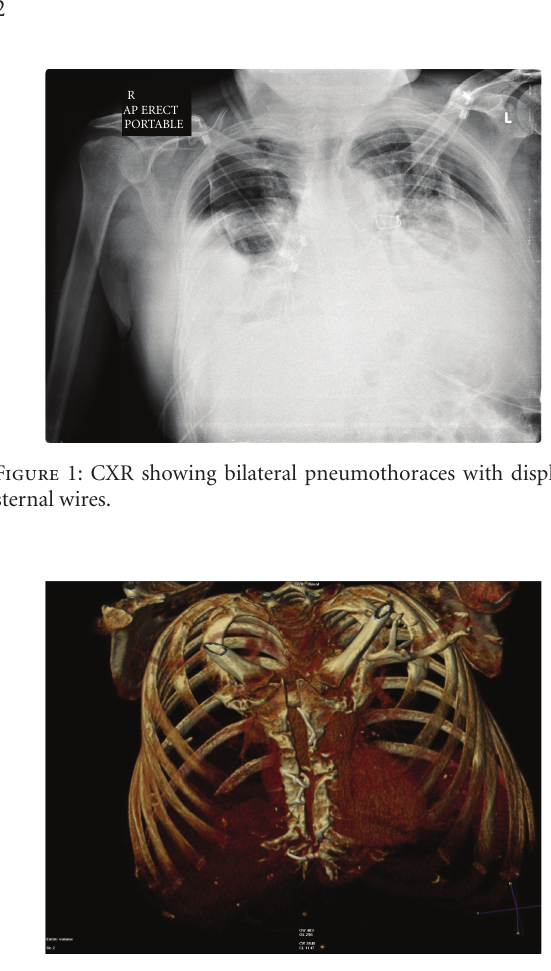
Figure 2: CT reconstruction of sternal dehiscence.